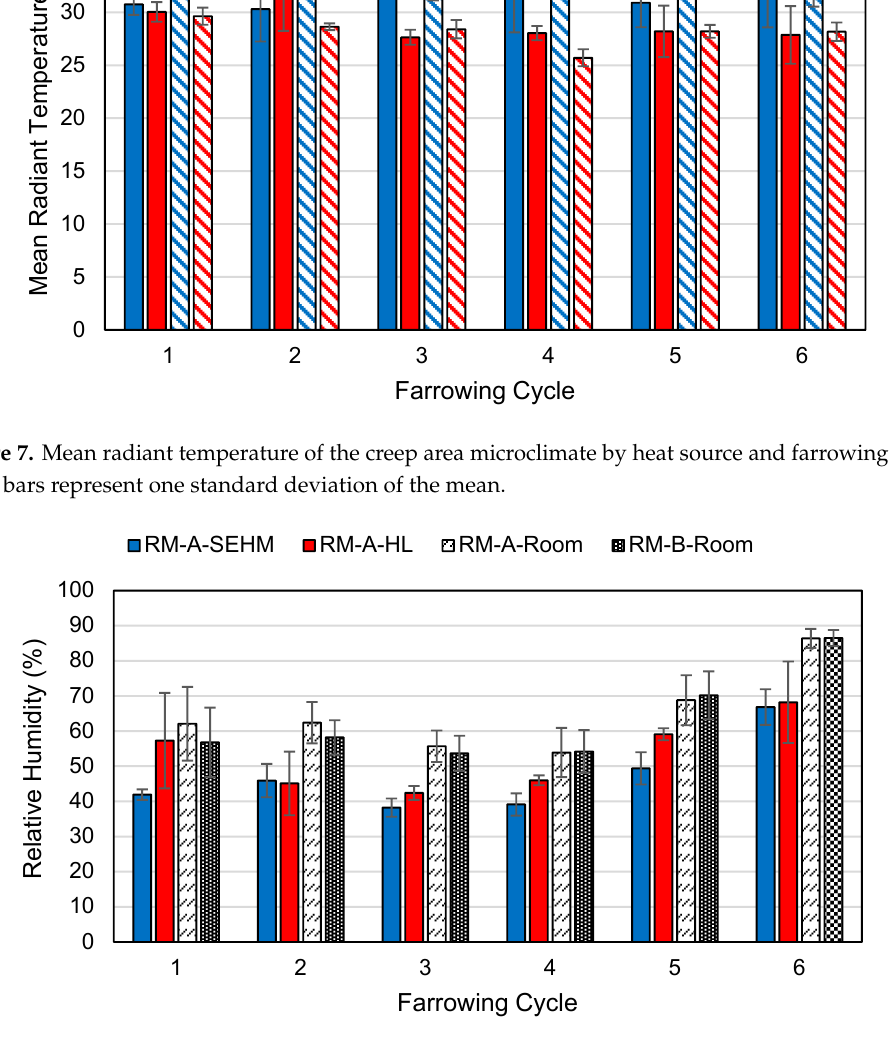
Figure 8. Relative humidity of the creep area microclimate in room A and the average relative humidity of room A and B macroclimate.